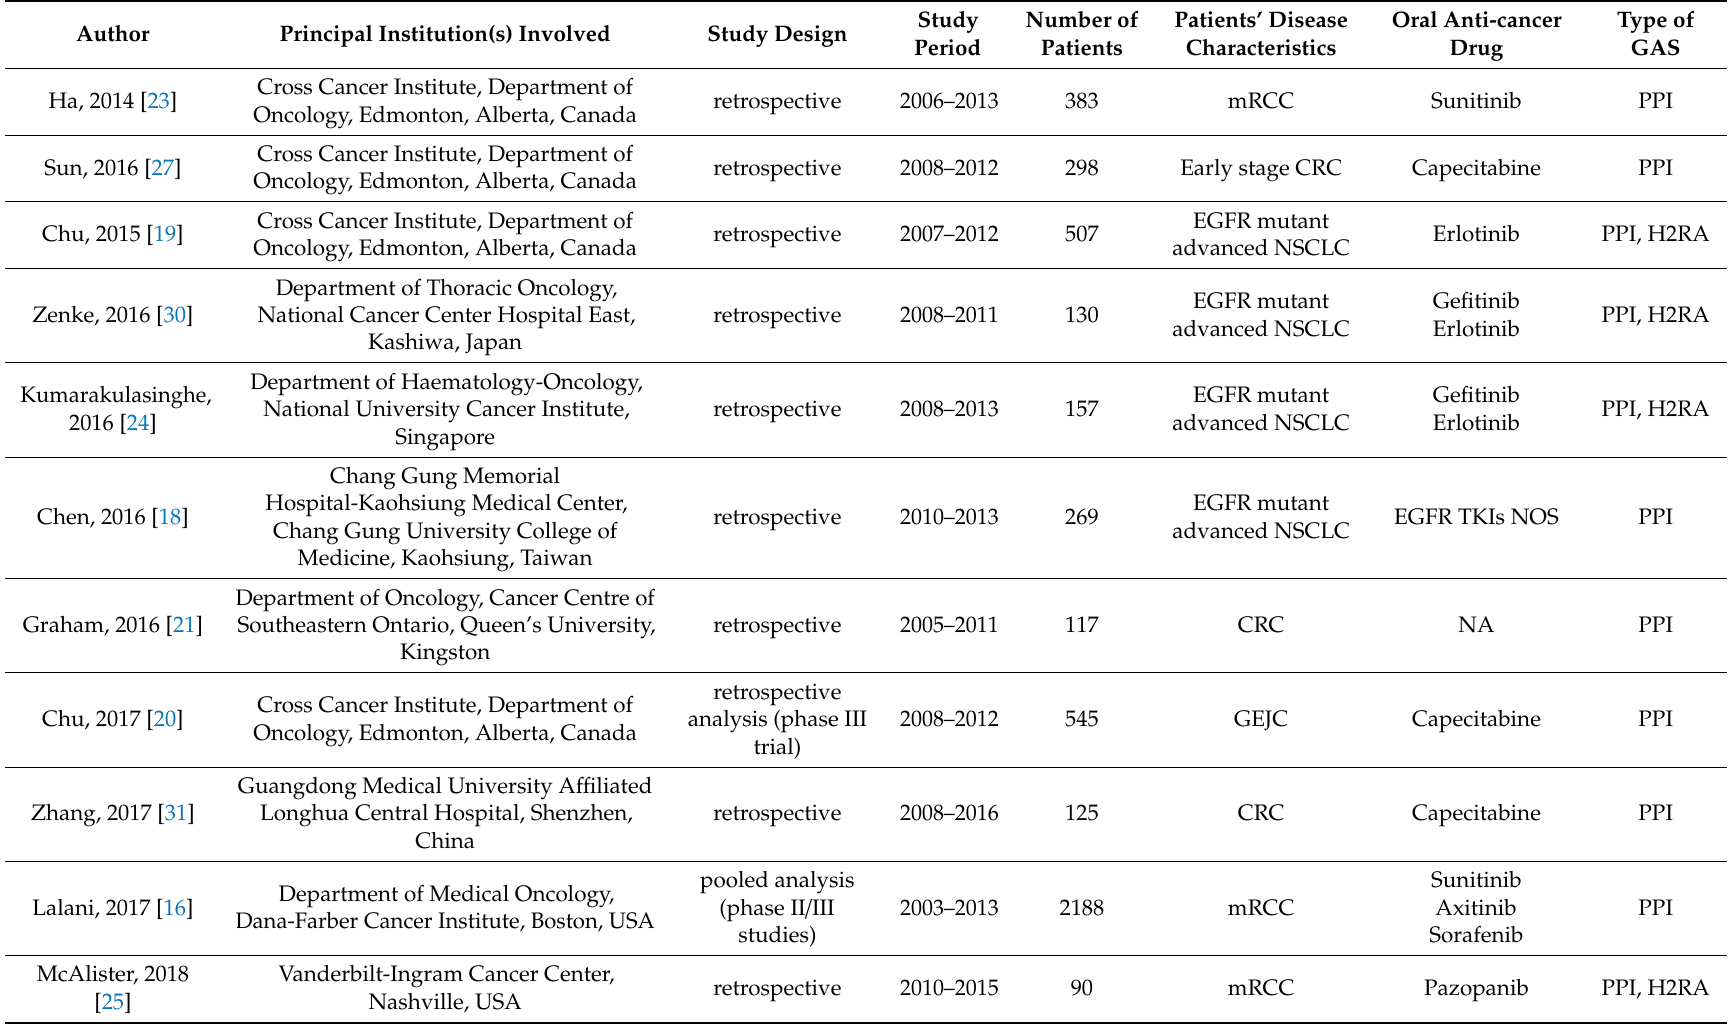
Table 1. Main characteristics of the included